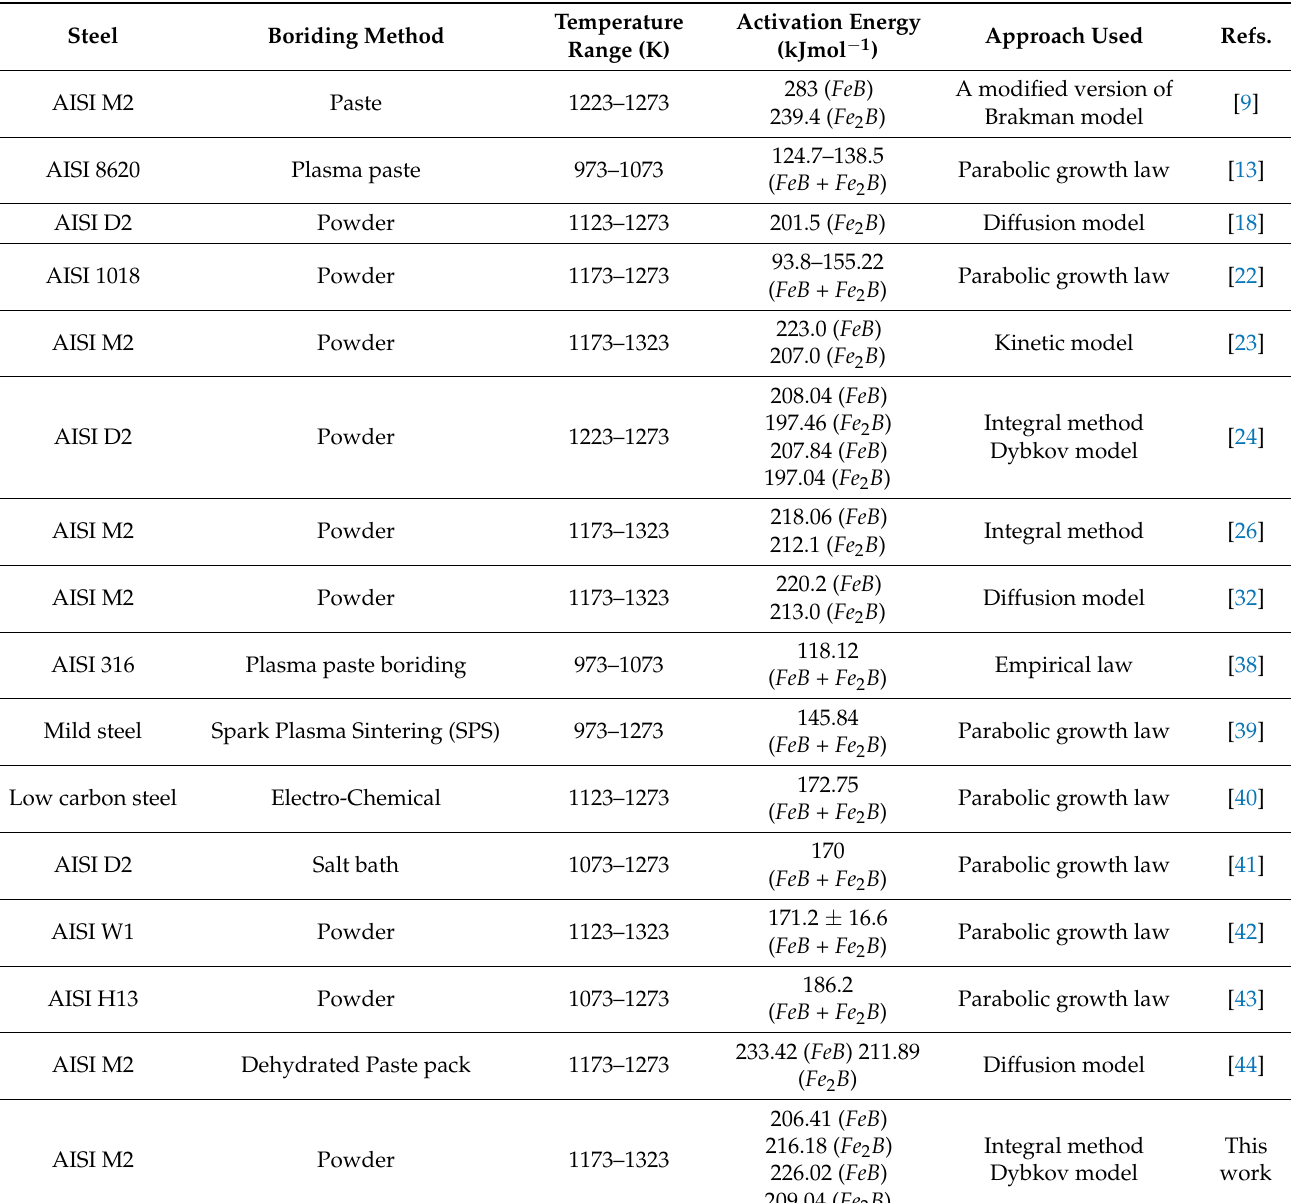
Table 5. Values of activation energies obtained on some borided